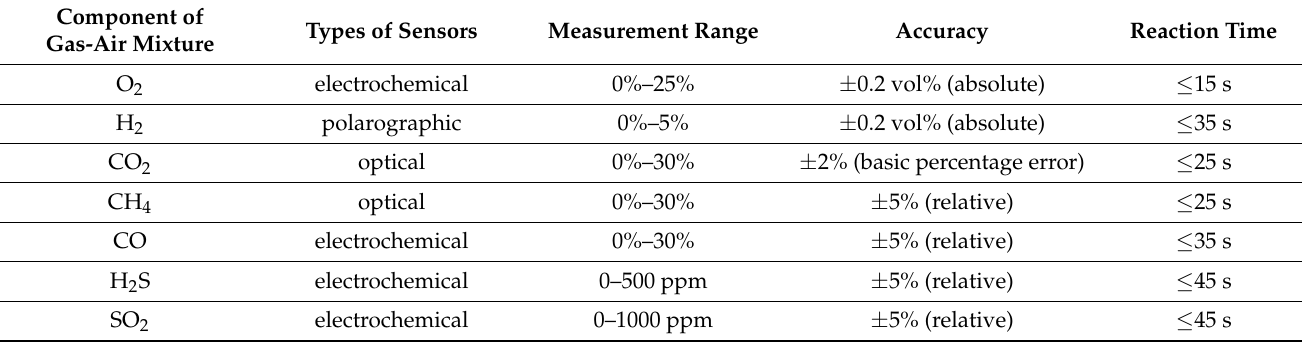
Table 3. Characteristics of the gas